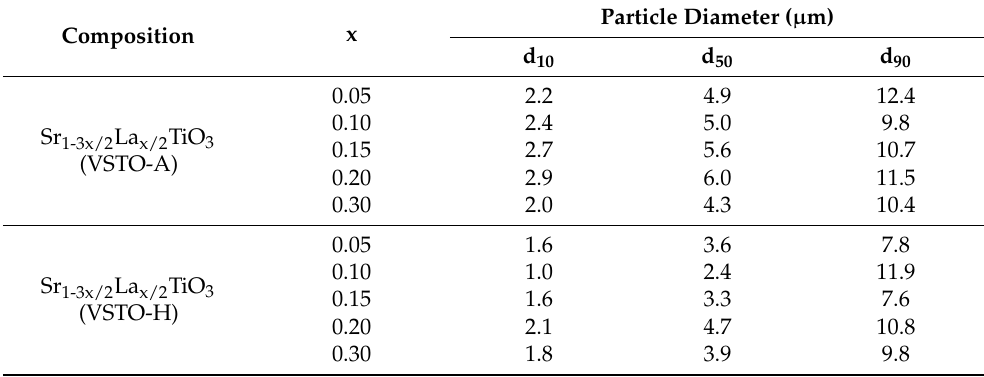
Table 1. Particle size analysis of calcined La + Sm co-doped SrTiO 3 powders after 24 h ball milling.